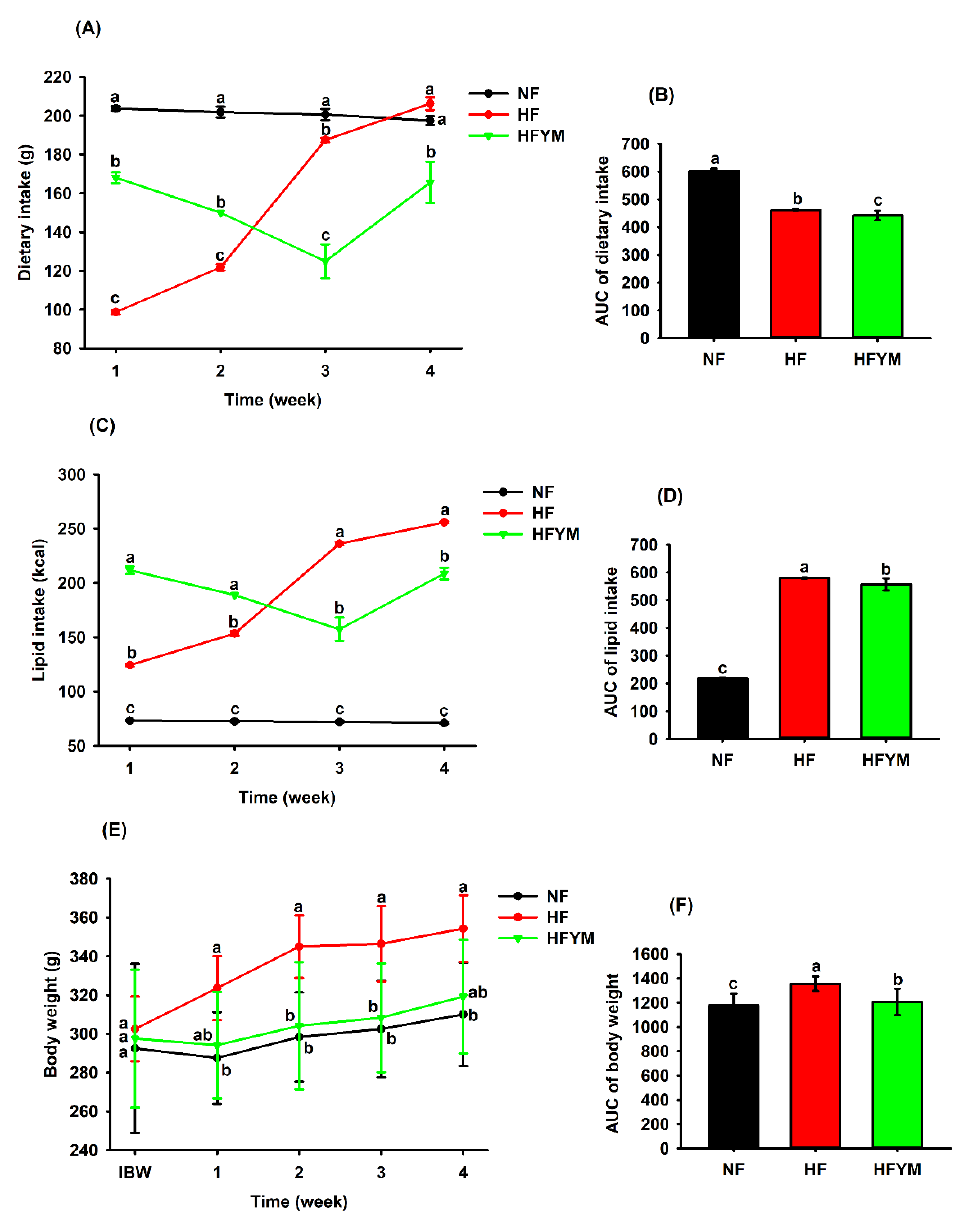
Figure 3. Dietary intake ( A ), lipid intake ( C ), body weight, ( E ) and respective areas under the curve — AUC ( B , D , F ). IBW = initial body weight; NF= normal-fat diet; HF= high-fat diet group; HFYM= high-fat diet group supplemented with yellow mombin. Data are represented with mean ± standard deviation. (a, b, c) Different lowercase letters at the same time or in the bars indicate that there was a statistical difference among the groups (one or two-way ANOVA followed by Tukey’s post-test, p ≤ 0.05).